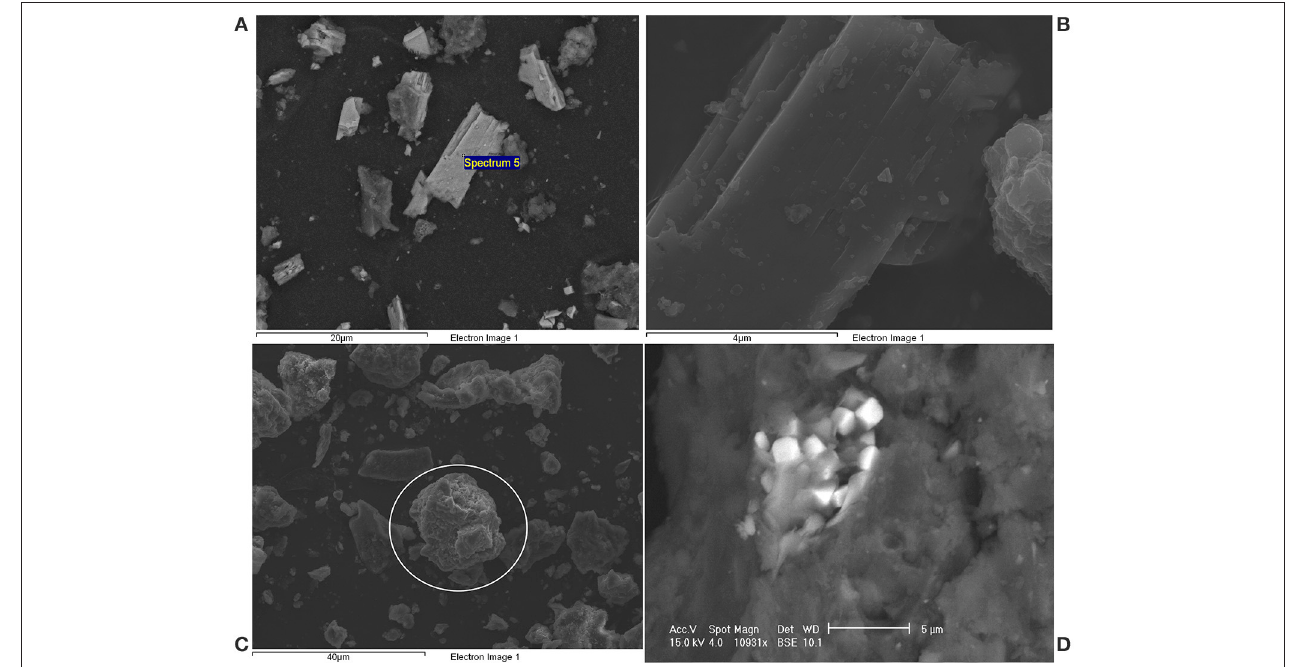
FIGURE 3 | Pictures of iron precipitates detected in anaerobically digested sludge by SEM-EDS. (A,B) Vivianite, (C) Ferrous sulphide, (D) Pyrite.